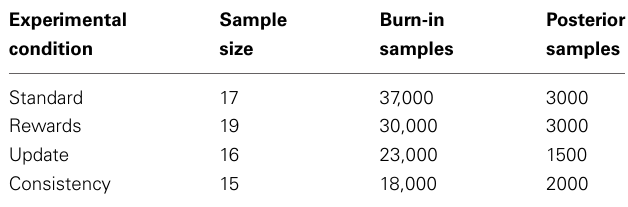
Table 5 | Sample size of the four data sets and number of burn-in samples and posterior samples that we collected for each